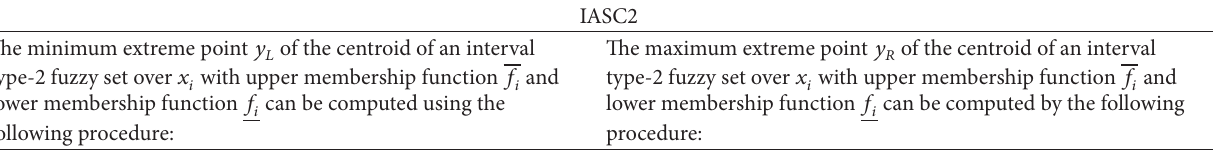
Table 1: IASC2 algorithm flow.